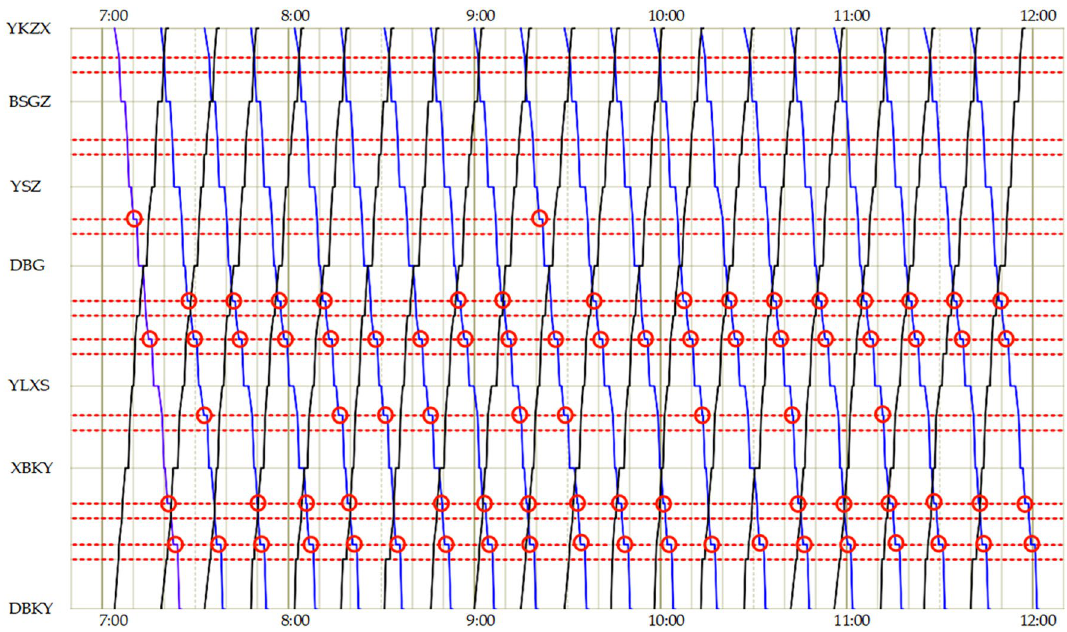
Figure 9. The tram timetable of the scheme for adopting the no-signal priority strategy